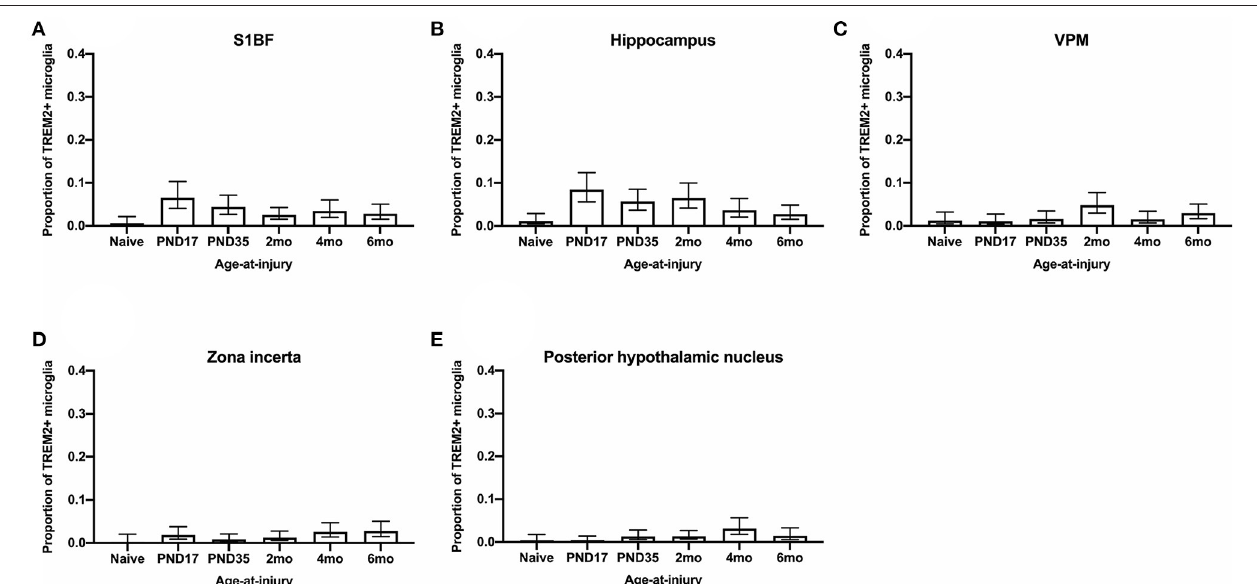
FIGURE 10 | The proportion of microglia colocalized with TREM2 were quantified in the S1BF, hippocampus, VPM, zona incerta, and posterior hypothalamic nucleus. Microglial colocalization with TREM2 is expressed as the proportion of TREM2 + microglia (mean ± 95%CI) in the primary sensory barrel field (S1BF), hippocampus, ventral posteromedial nucleus (VPM), zona incerta, and posterior hypothalamic nucleus. Significantly more TREM2 + microglia were observed following mFPI compared to naïves in the S1BF (A) , regardless of whether the TBI was recent or remote. However, in the hippocampus (B) , a greater proportion of microglia colocalized with TREM2 was only evident compared with naïves with a more remote TBI (see Table 14). This trend is the opposite in the zona incerta (C) , VPM (D) , and posterior hypothalamic nucleus (E) , where a greater proportion of microglia colocalized with TREM2 was only evident compared with naïves with a more recent TBI (see Table 5